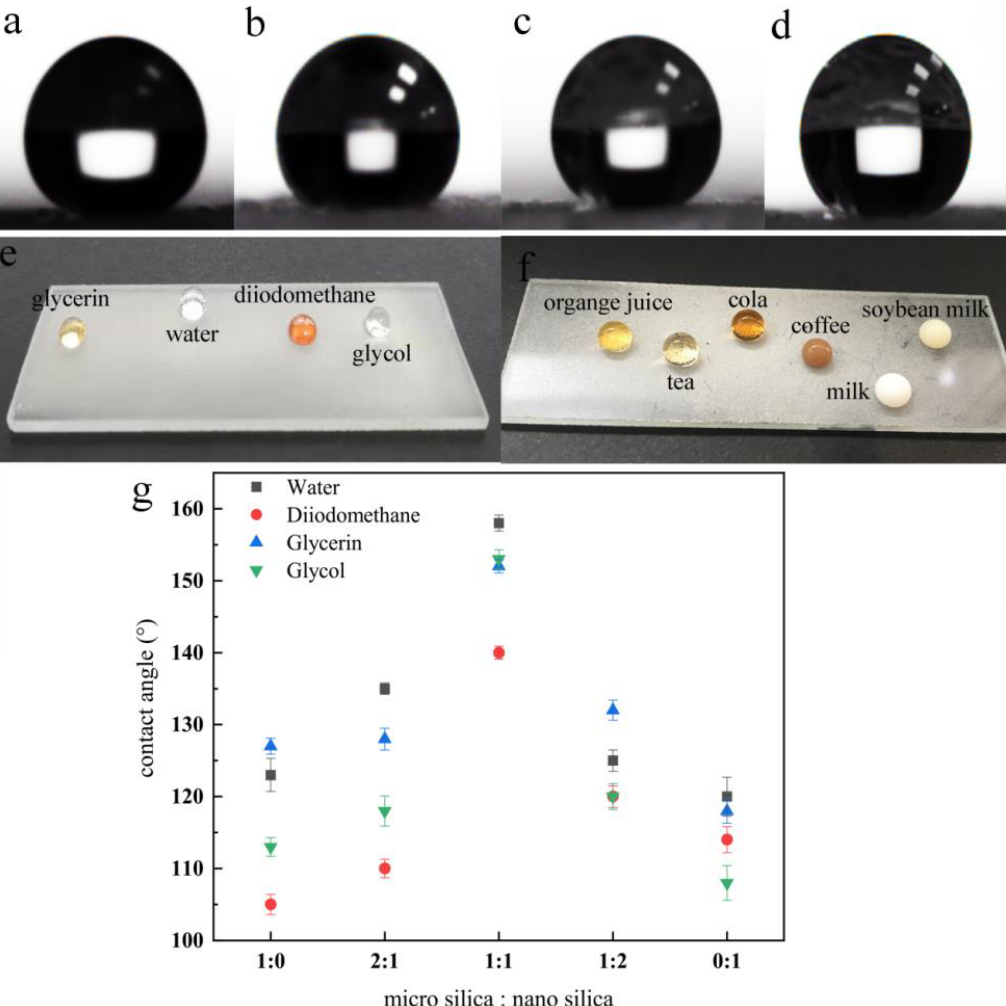
Figure 5. CAs of FEP-S slide for ( a ) water ( b ) diiodomethane ( c ) glycerol and ( d ) ethylene glycol ( e , f ) droplets of different liquids on FEP-S slide ( g ) CA for different liquids of coatings with different proportions of micro/nano-silica. Table 3. SAs for different liquids of FEP-S coatings (proportions of micro/nano-silica is 1:1). SAs (°)